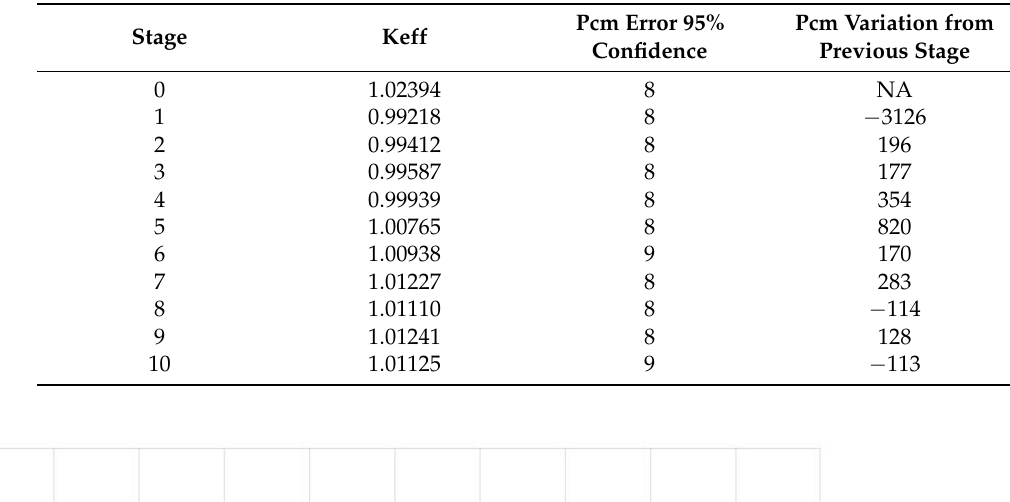
Table 8. Full core K eff iterations between Serpent and CTF.